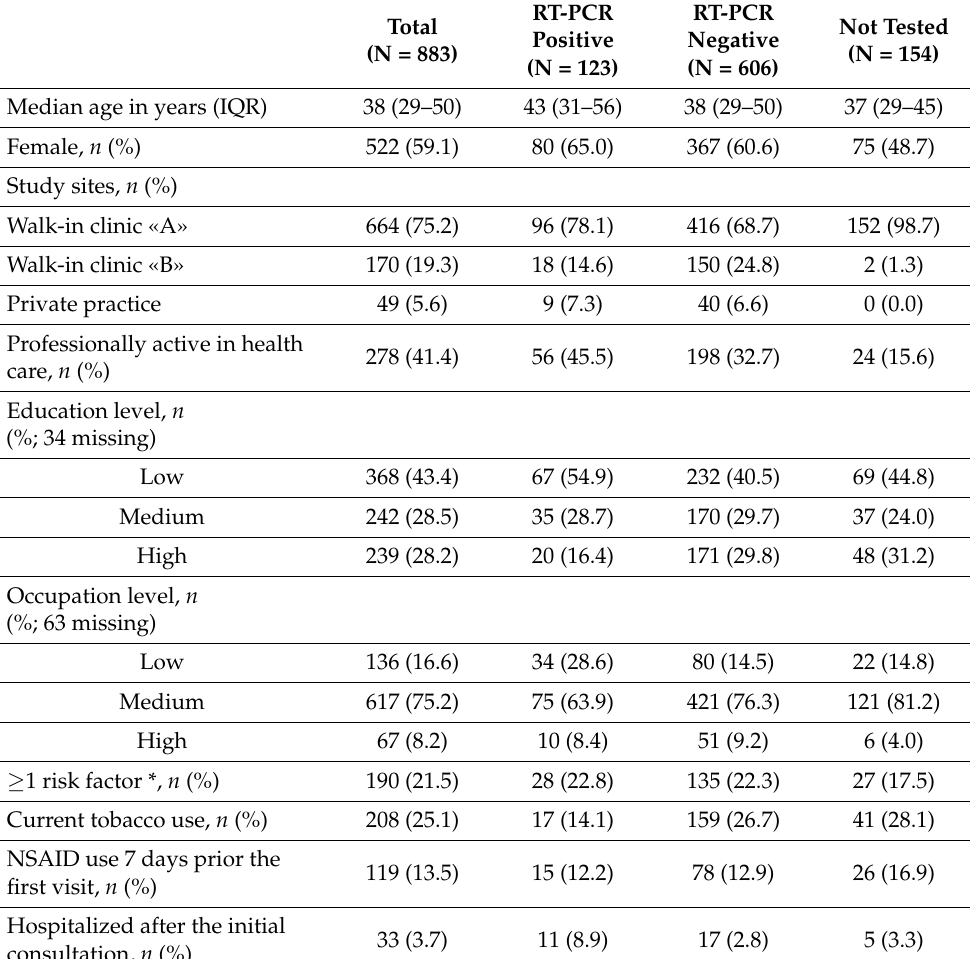
Table 1. Sociodemographic and clinical characteristics of the participants by SARS-CoV-2 RT-PCR testing and test results. COVID-AMBU study, March–July